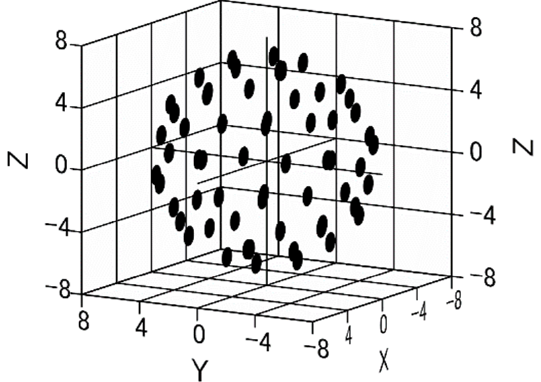
Figure 20. Plots of atom positions in 3D coordinates of a C 60 fullerene located on a sphere of radius